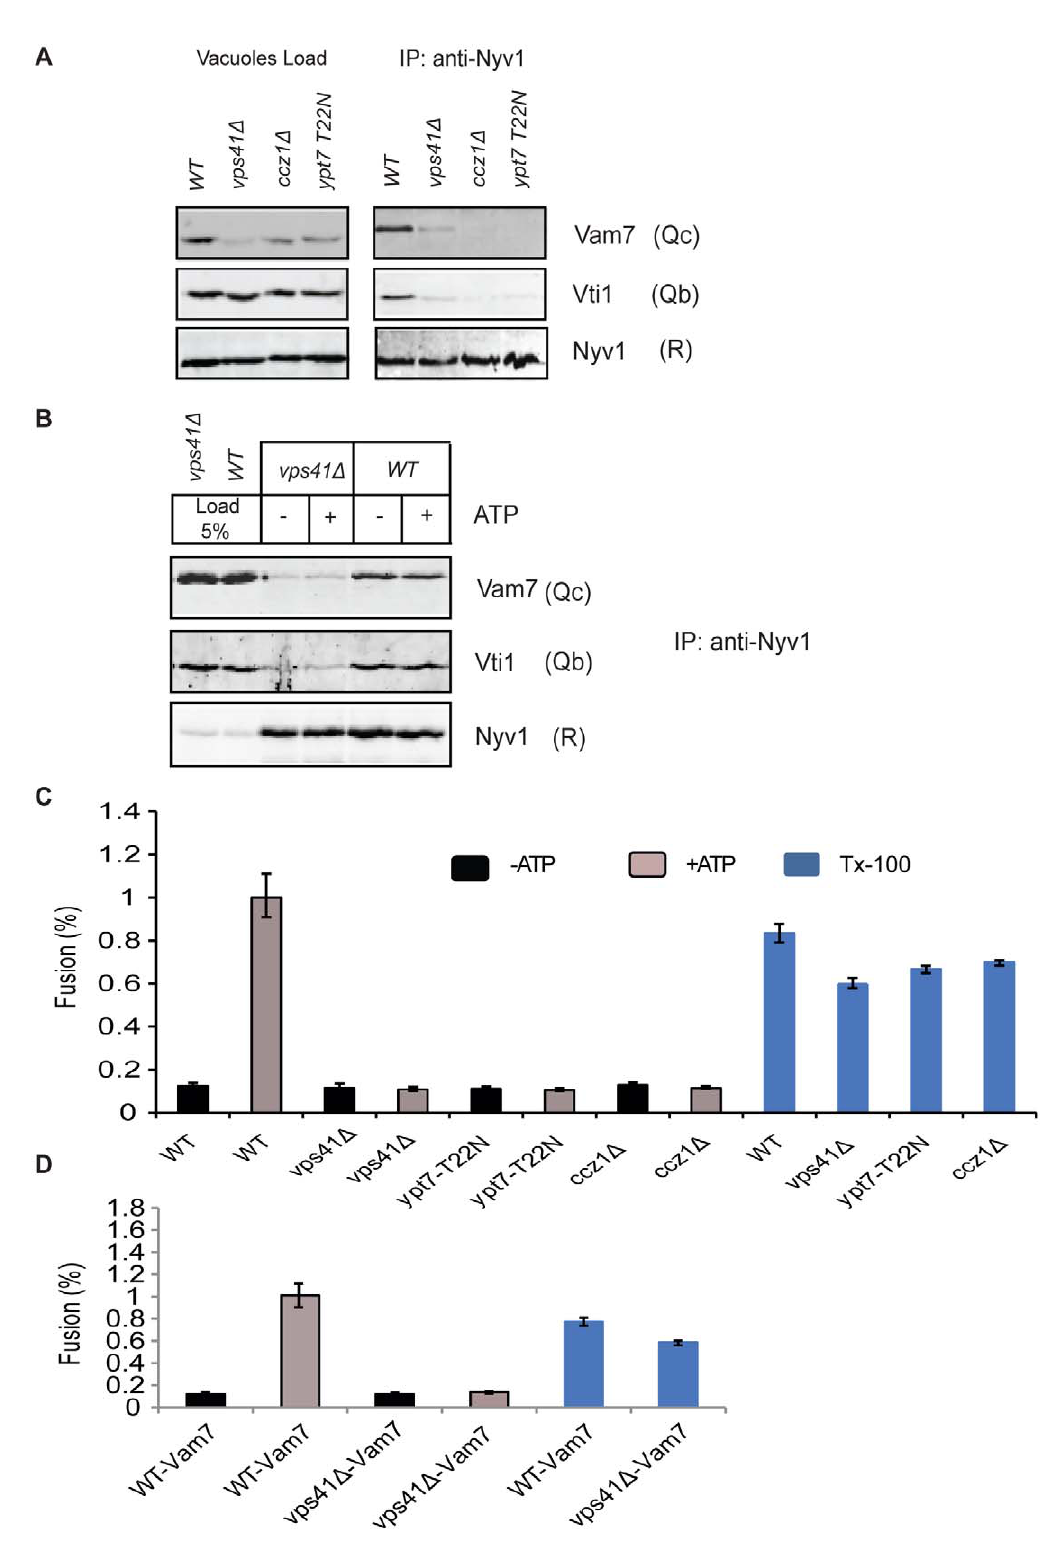
Figure 6. Q bc R-SNARE complexes on tether-mutant vacuoles. (A) Presence of Q bc R complexes on tether mutant vacuoles assayed by precipitating Nyv1. The left panel depicts expression levels of SNAREs on purified wildtype, vps41 D , ccz1 D , and ypt7-T22N vacuoles; the right panel shows precipitated QQR-complexes from these vacuoles in the absence of ATP. (B) Vam7-overexpression on vps41 D vacuoles does not restore Q bc R- complex formation. Vam7 was over-expressed in wildtype and vps41 D strains, and Q bc R-complex formation was assayed by precipitating Nyv1 in the presence and absence of ATP. (C) Fusion rates of wildtype and tether-mutant vacuoles. Vacuoles were fused under standard fusion conditions. TX-100 values depict ALP maturation of mixed vacuoles in the presence of 0.2% Triton X-100 and therefore show the amount of reporter loading. Three PLoS Biology |